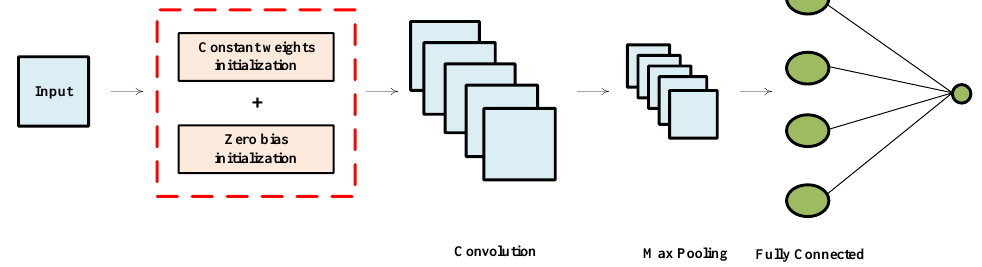
Figure 4. Weights and bias.